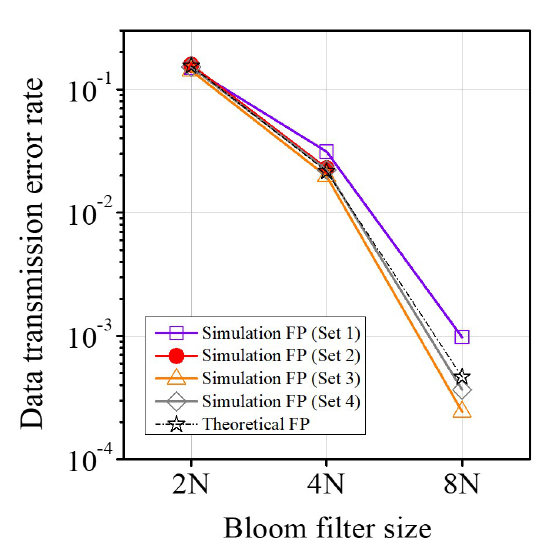
Figure 8. Data transmission error rate.